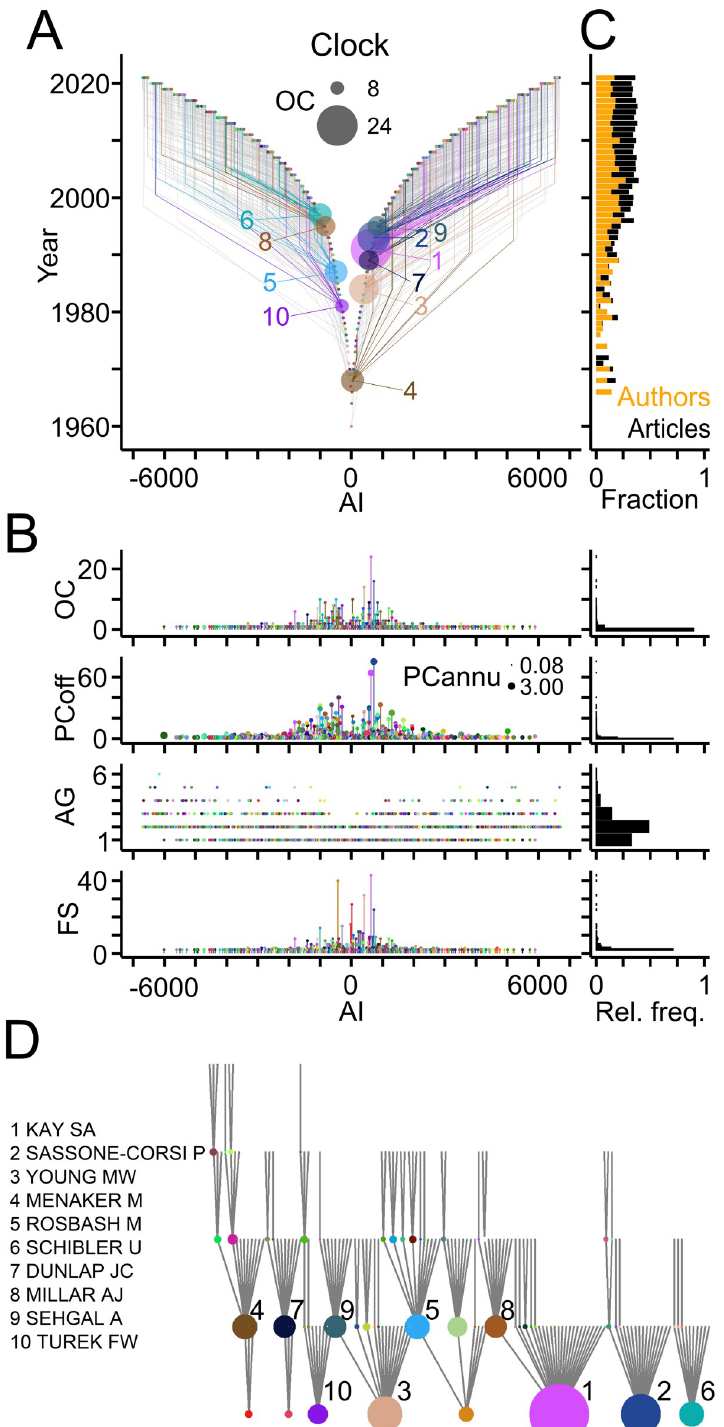
Fig 4. Genealogical relations in the Clock field. (A) TTG showing genealogic relations with circles and grey lines indicating ancestor—offspring connections derived from last author—first author pairs of publications. Connections of authors with the ten largest offspring count (OC) values are shown in color (names indicated in panel D). Circle area indicates OC. AI signs of offspring and of ancestors were adjusted to the first generation ancestor. (B) Left, from top to bottom, OC values, number of articles with offspring (PCoff), author generation (AG) and family size (FS). Circle area indicates PCannu. Right, relative frequency distributions of parameters shown on the left. (C) Fraction of offspring authors (orange) entering the field and of publications with offspring (black) compared to total numbers per year. (D) Names and family connections of authors with top ten OC values indicated by circle area. https://doi.org/10.1371/journal.pone.0253847.g004 PLOS ONE | https://doi.org/10.1371/journal.pone.0253847 July 21,